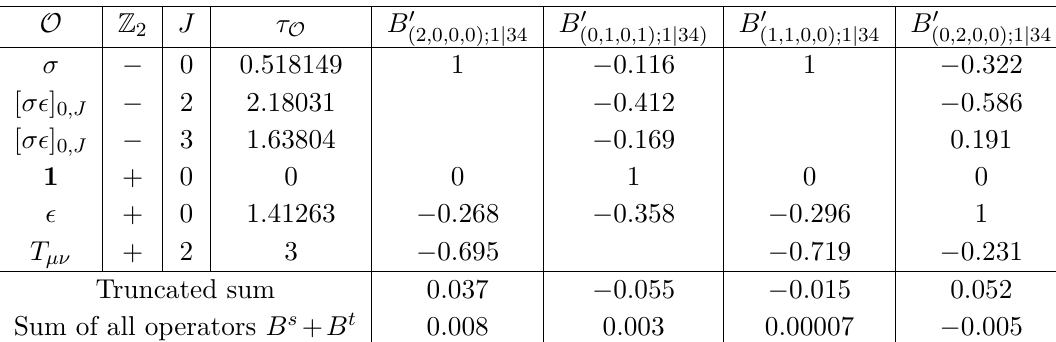
Table 10 . Contribution of each operator to the derivative B 0 functional acting on the h σσ(cid:15)(cid:15) i correlator with v = 1 ; these results include the contribution of the OPE coefficients f The values are presented as ratios of the individual operator relative to the largest contribution to the sum rule. Empty cells contribute at order O (10 − 2 ) and